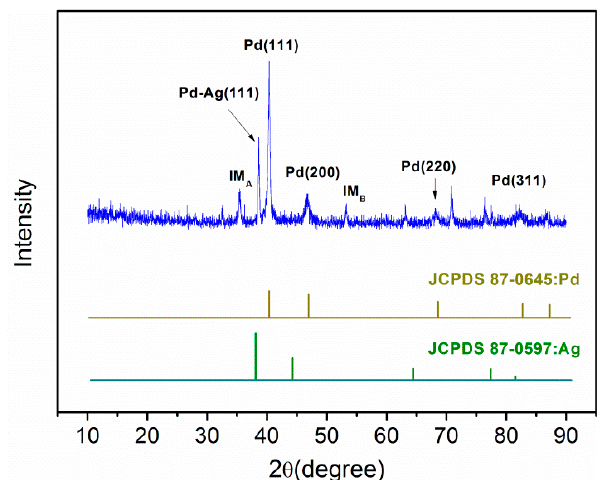
Figure 4. XRD pattern of the Pd-Ag/PPY/Ti electrode.